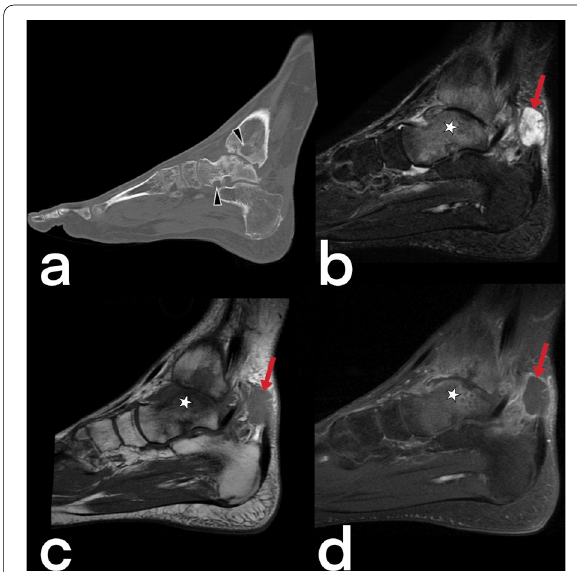
Fig. 53 Sagittal reformatted CT ( a ) and MR images ( b – d ) of a 48-year-old male. CT image shows focal low-attenuation areas in the distal part of the tibia in keeping with abscesses and bone destructions (arrowheads). On sagittal T2-weighted ( b ), pre-contrast T1-weighted ( c ), and post-contrast T1 weighted ( d ) MR images reveal extensive signal intensity change within the bone marrow of the talus and distal tibial part (stars). MR images also demonstrate an abscess in the adjacent soft tissue to the Achilles tendon (arrows)